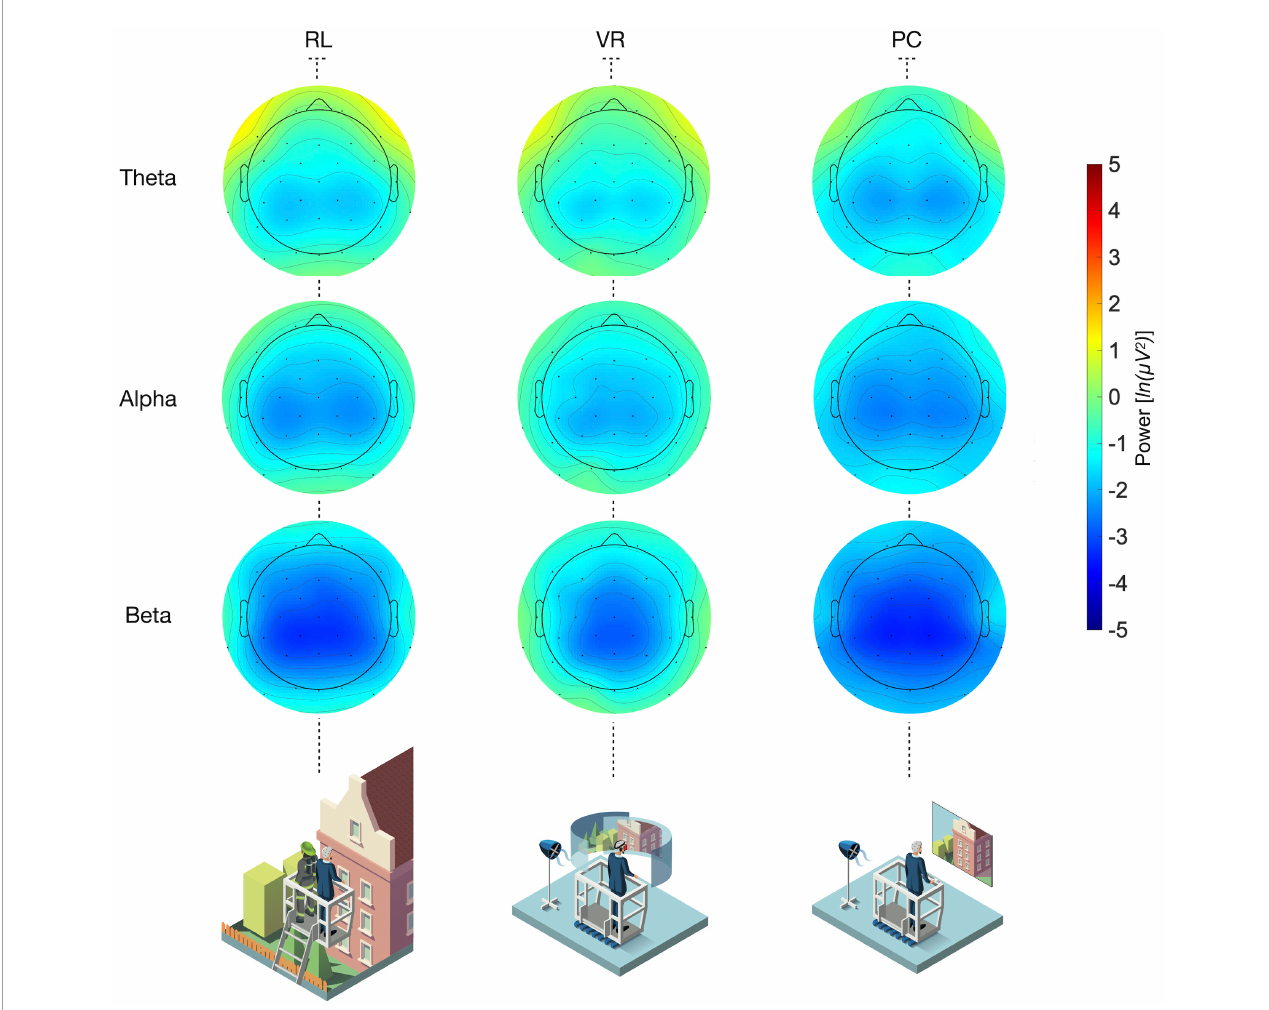
FIGURE2 Average topographic oscillatory power amplitude [ln( µ V2)] distribution across participants by frequency band (rows) and conditions (columns) while staying at the highest point of the ride in the fire trucks basket. The pictograms in the last row depict the experimental setup per condition. See Supplementary Figure 11 for the topographical distribution separately per phase and frequency band